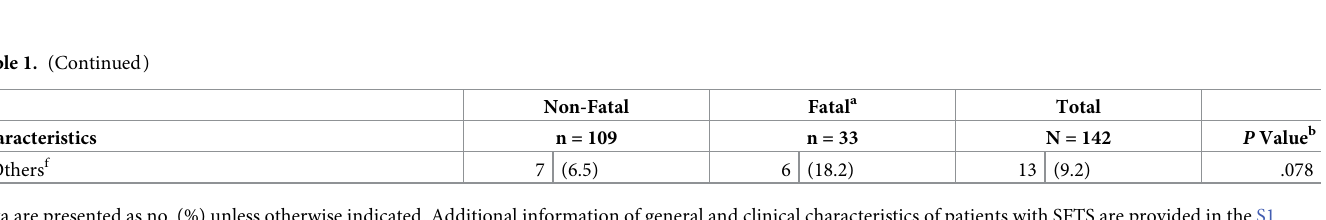
Abbreviations: APACHE, acute physiology and chronic health evaluation; CRRT, continuous renal replacement therapy; DIC, disseminated intravascular